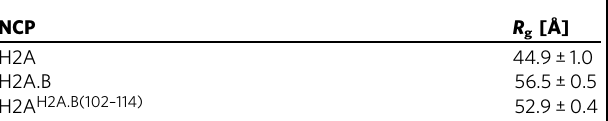
Table 2 SAXS analyses of the H2A, H2A.B, and H2A H2A.B (102 – 114) NCPs.